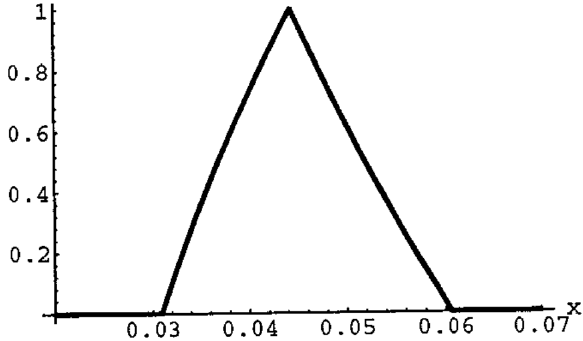
Figure 4. Membership function for the growth index.